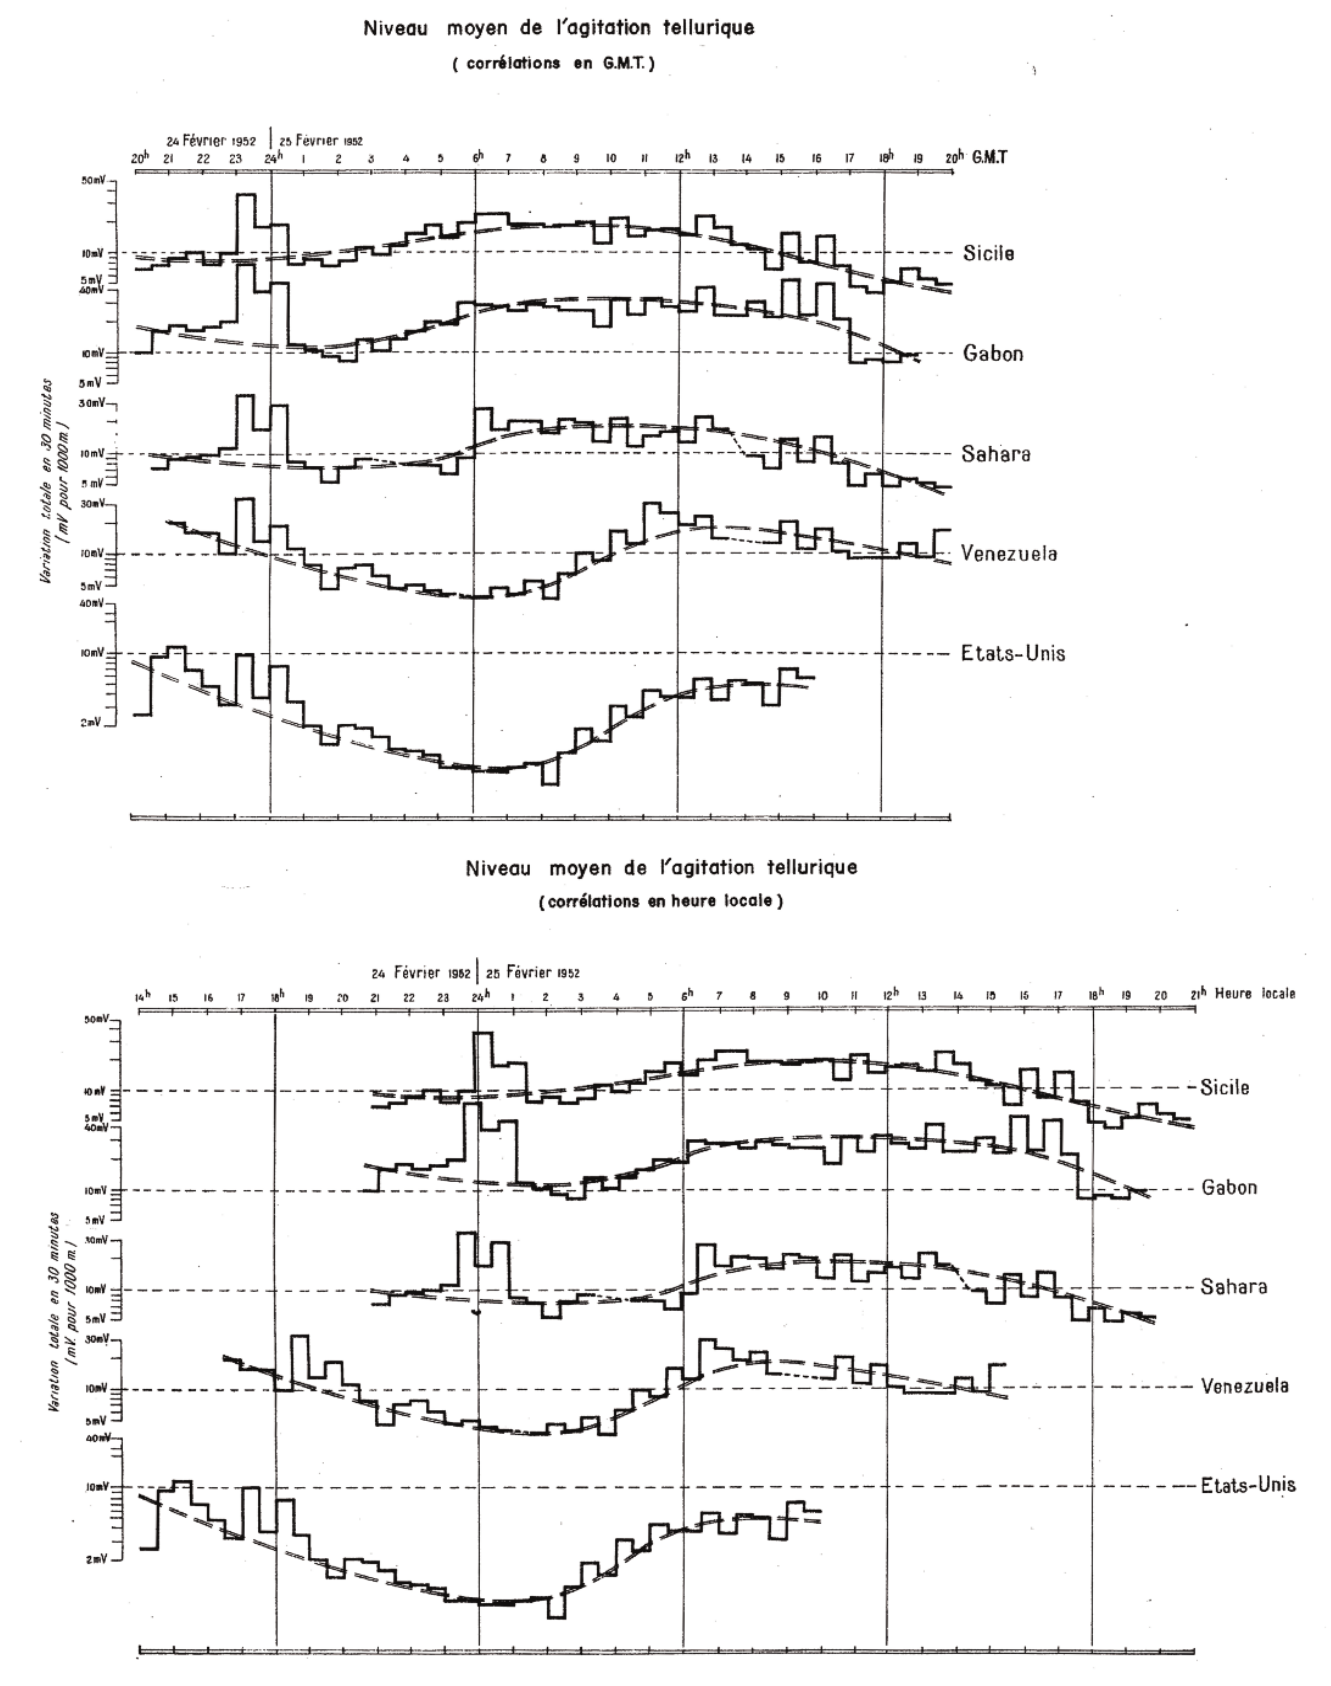
Figure 11. Niveau moyen de l’agitation tellurique, les 24 et 25 février 1952. 1) Corrélations en temps universel; 2) Corrélations en temps local (d’après